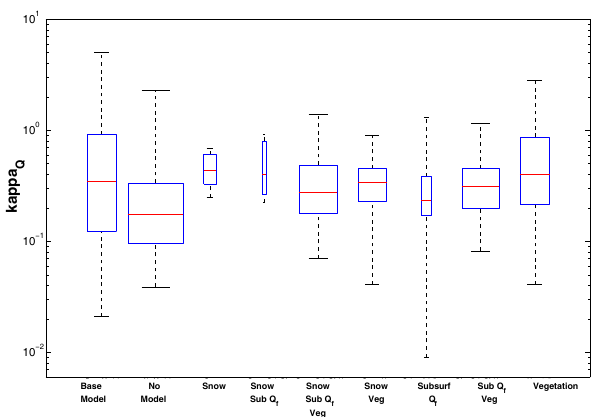
Fig. 7. The parameter κ of the mixed gamma distribution for to- tal streamflow grouped by dominant model process. Note that box width reflects number of catchments in each group.